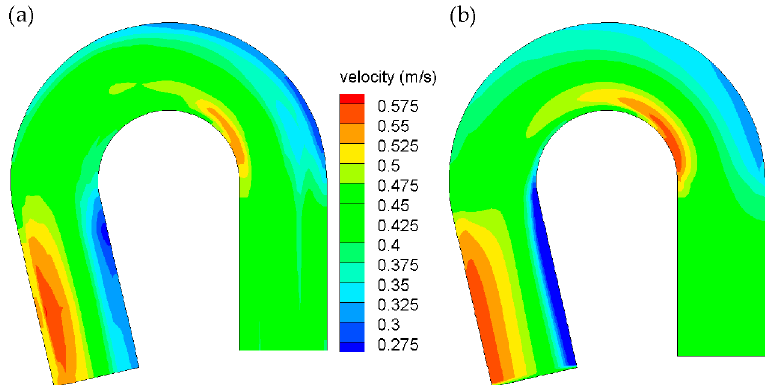
Figure 4. Distribution of the depth-averaged streamwise velocity: ( a ) Experiment; ( b ) modelling.